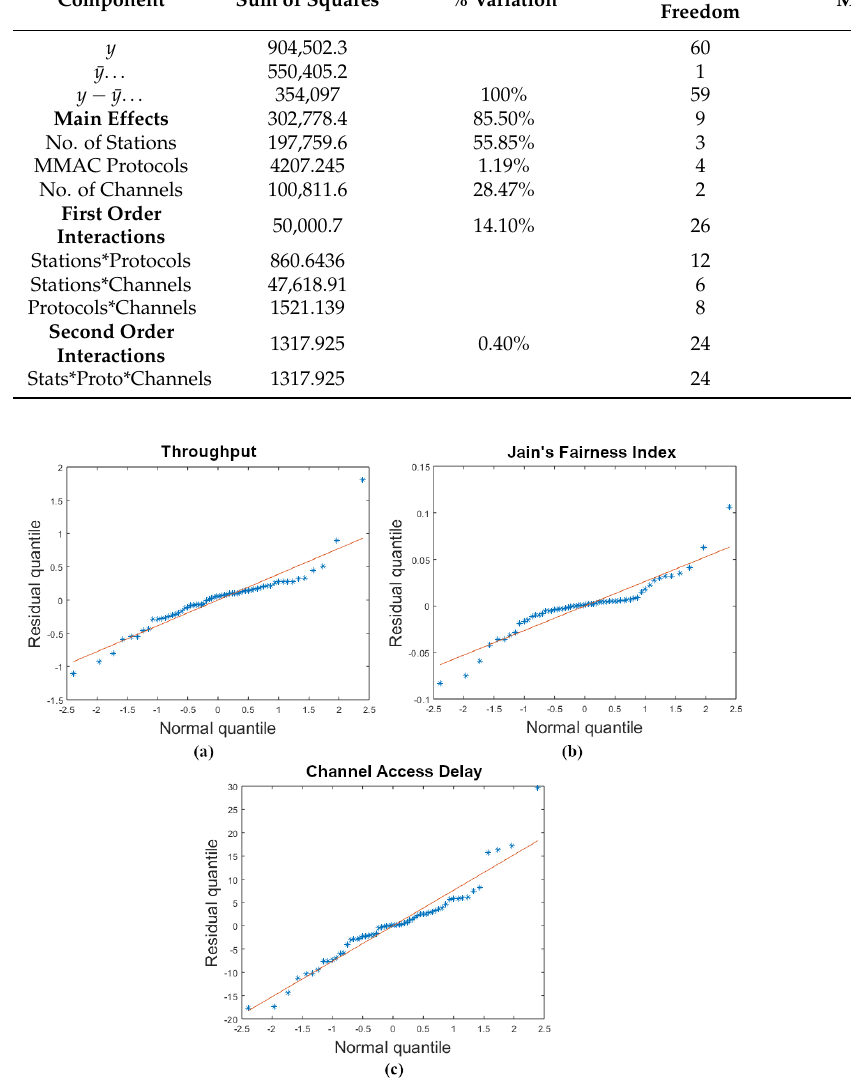
Figure 11. Quantile–quantile plot of ( a ) throughput, ( b ) JFI, and ( c ) channel access